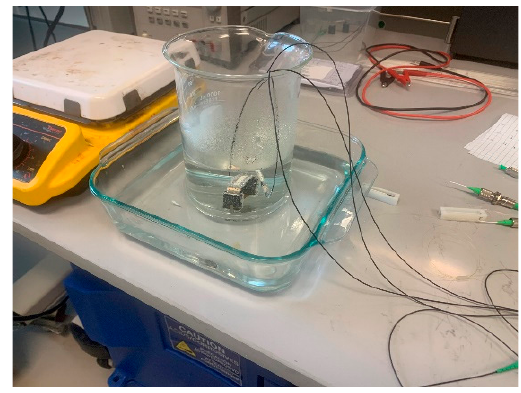
Figure 22. Room temperature water bath.